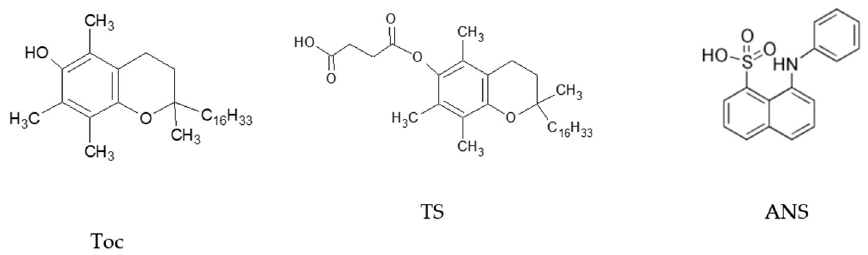
Figure 10. Chemical structures of α -tocopherol (Toc), its ester derivative succinate (TS) and 1-anilino- 8-naphtalene sulphonate (ANS).